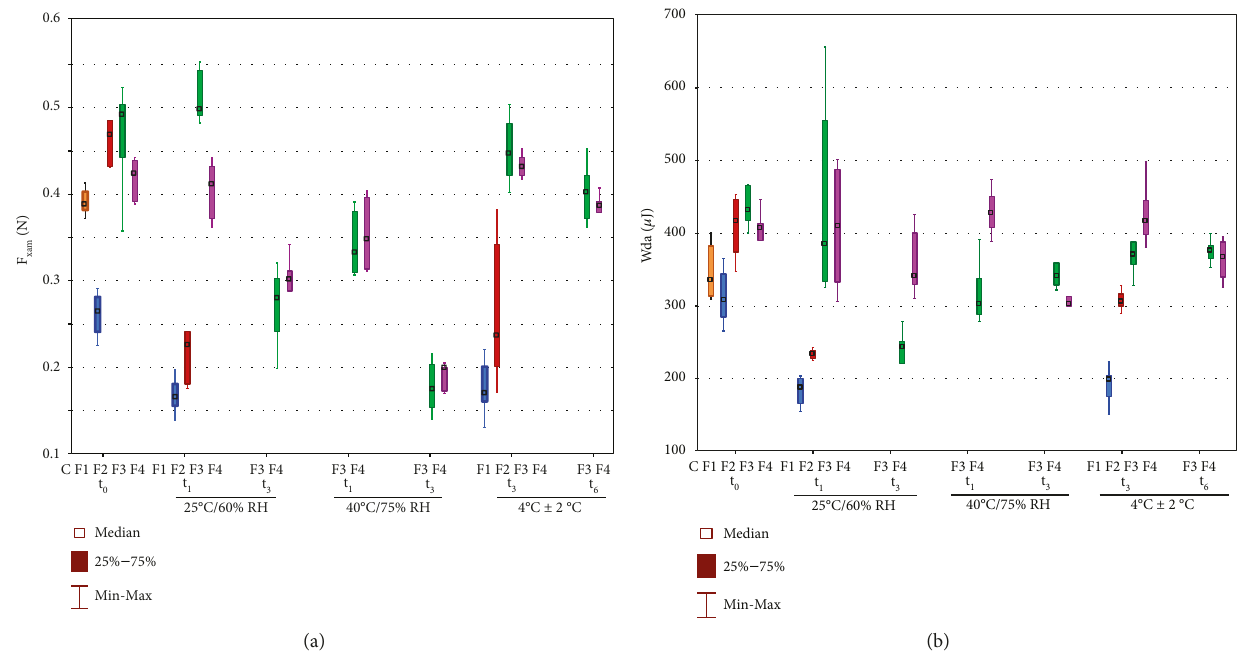
W max ) and (b) work of adhesion ( ad ) of